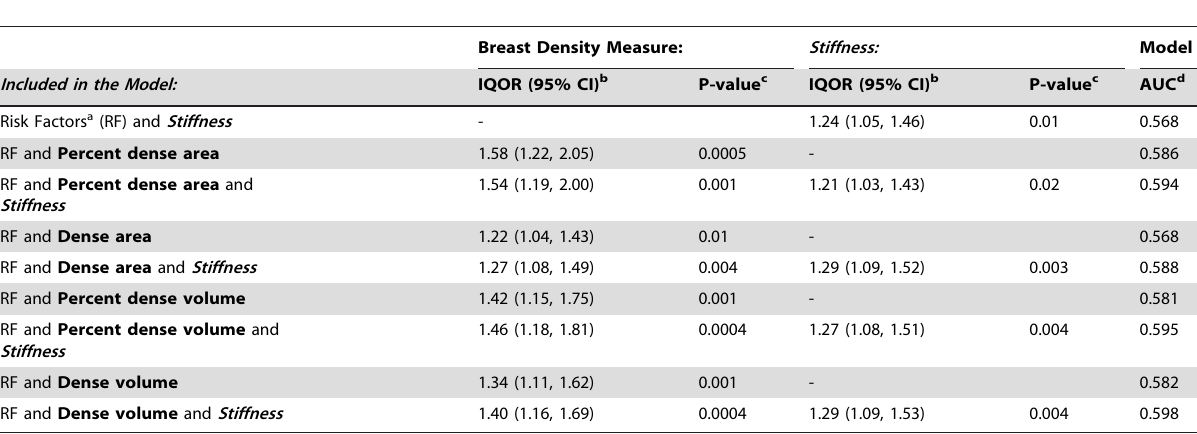
Table 3. Mammographic measures, stiffness and breast cancer risk.